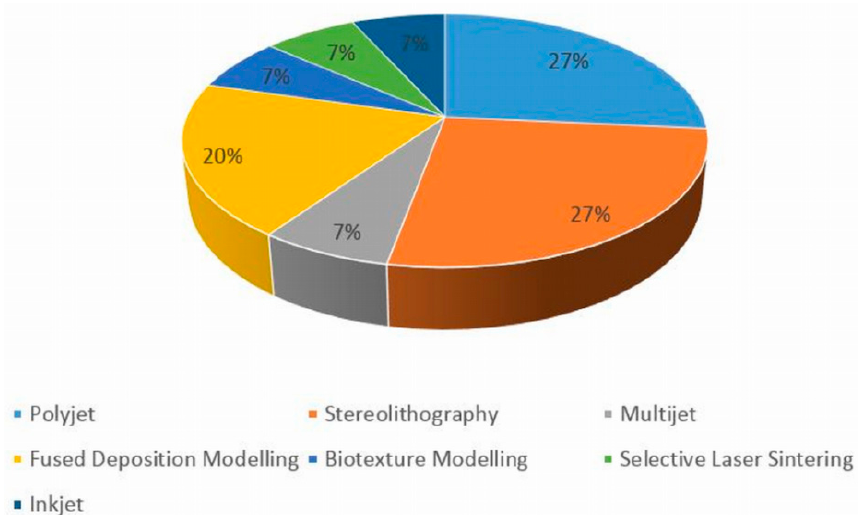
Figure 3. Comparison of di ff erent 3D-printing technologies utilised according to the review of these studies.